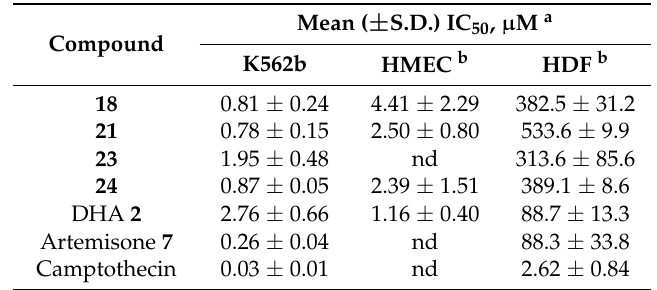
Table 2. Cytotoxicities of N -glycosylated DHA piperazine derivatives against the myelogenous leukemia cell line K562, human dermal endothelial cells HMEC-1, and fresh human dermal fibroblasts